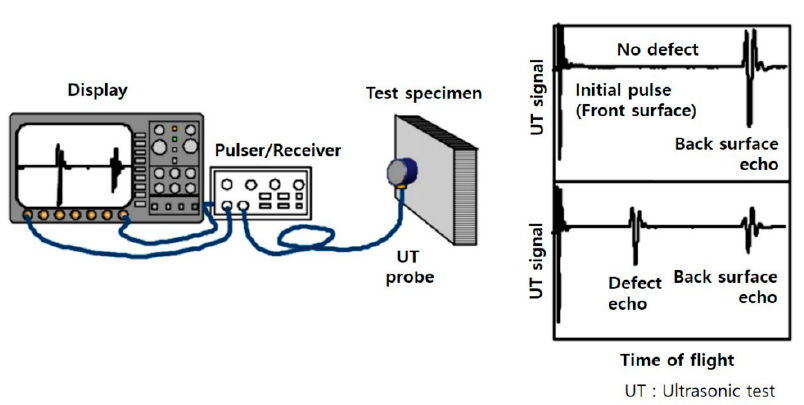
Figure 1. Example of pulse-echo ultrasonic testing; reprinted with permission from ref. [22]. 2009 Shant Kenderian.